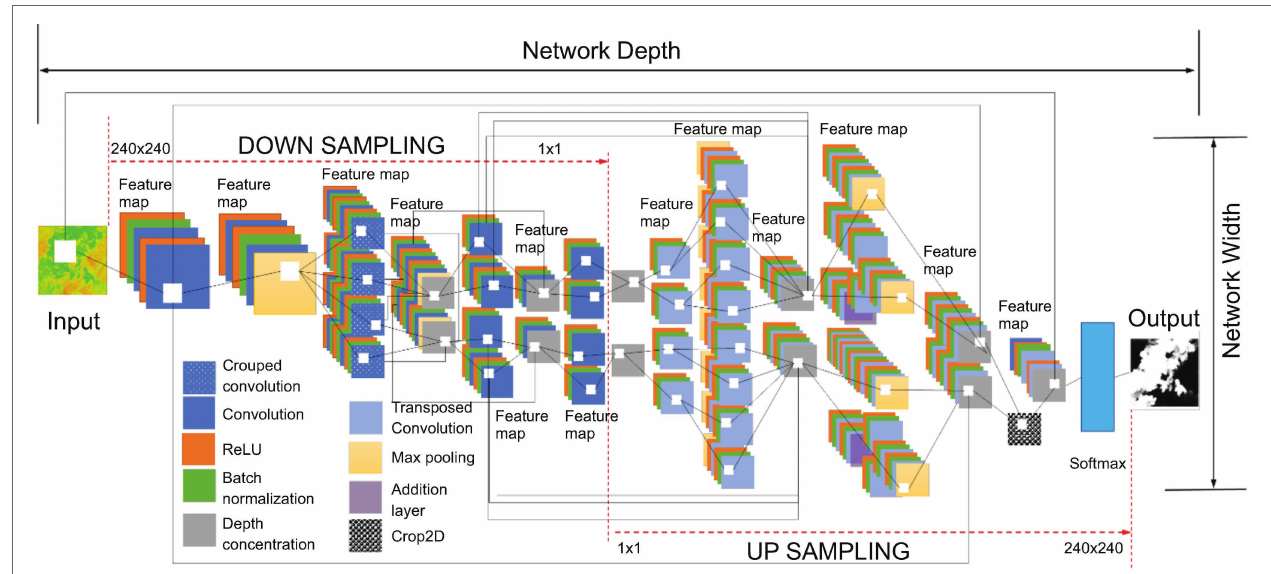
FIGURE 7 | The basic network architecture of the